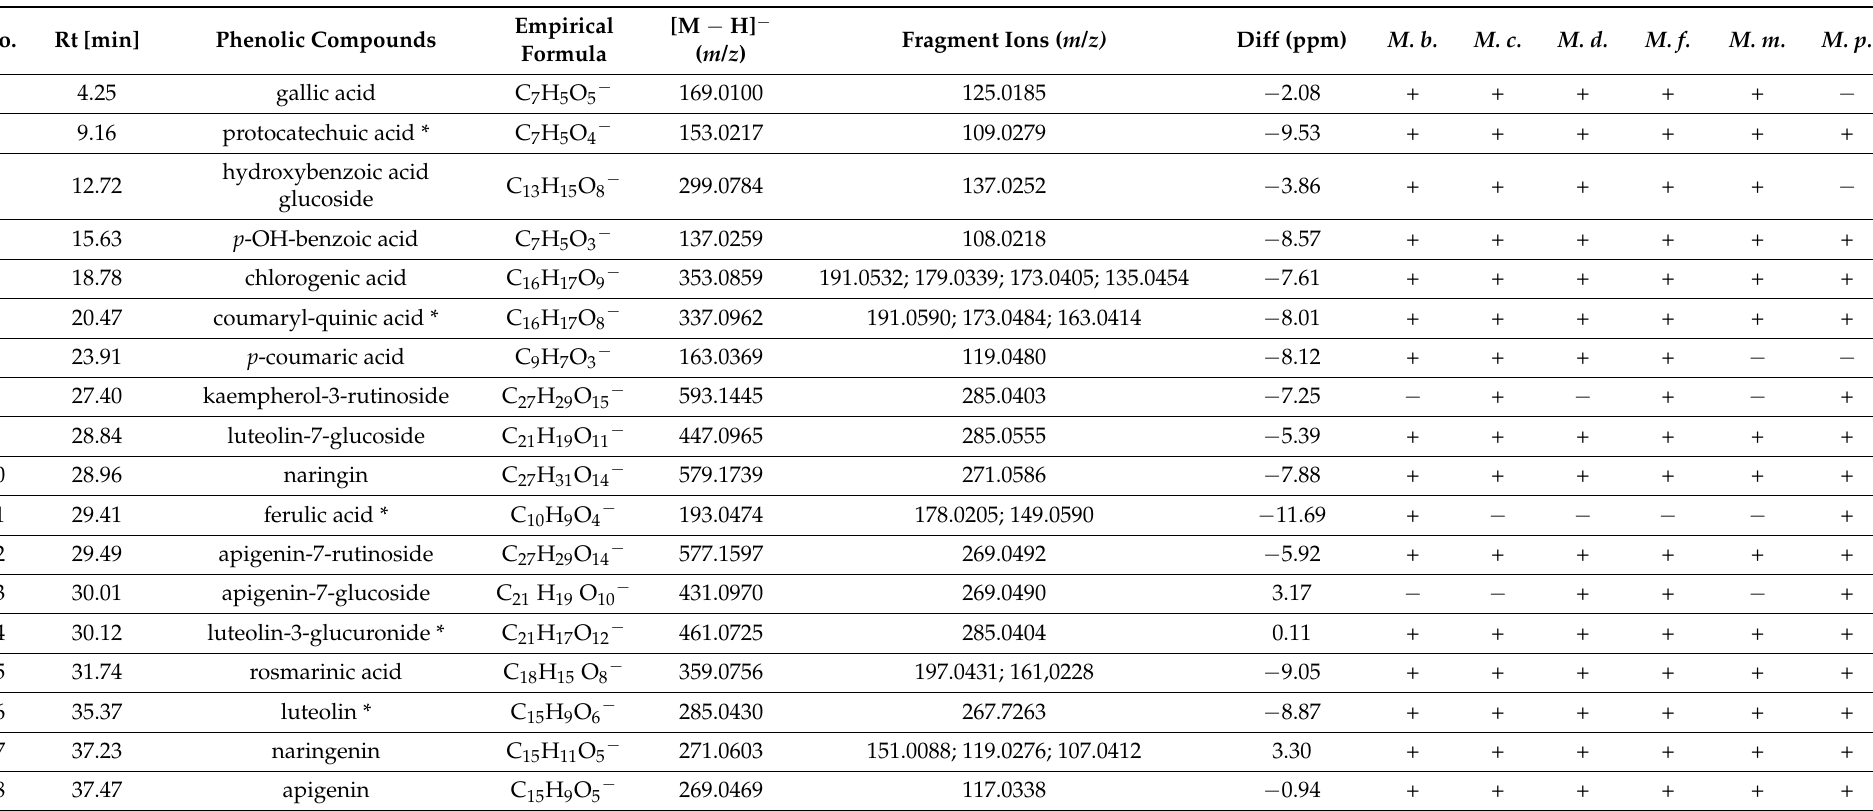
Table 1. Analysis of phenolic compounds by HPLC–DAD–ESI-QTOF-/MS/MS in 70% ( v/v ) methanolic extracts of Monarda species. (Rt—retention time, *—the components that were identified also based on a direct comparison with